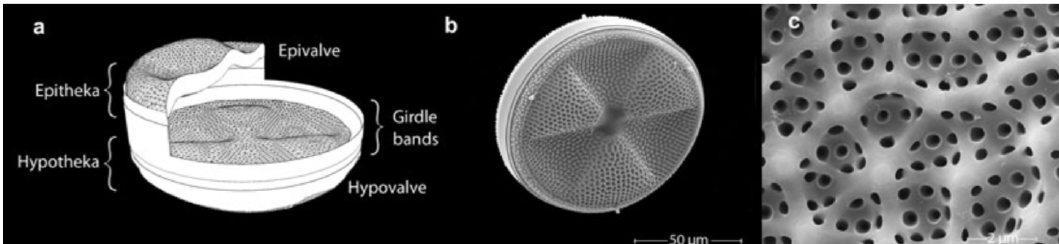
Figure 1. ( a ) 3D schematic model of an Actinoptychus senarius frustule with indication of the single components. ( b ) Scanning electron microscope (SEM) image of the whole frustule. ( c ) Detail of the valve. Reproduced with permission from Ref. [23].